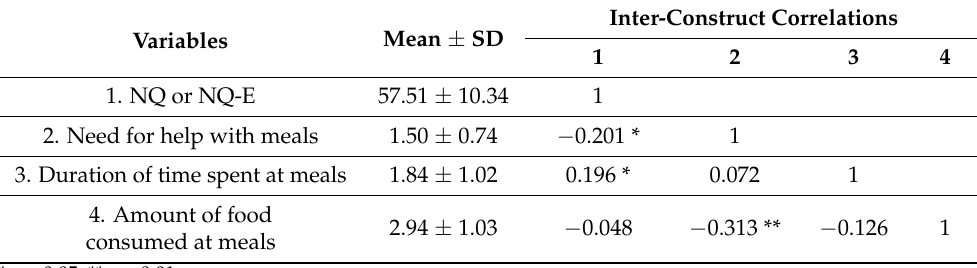
Table 9. Correlation between Nutrition Quotient/Nutrition Quotient for the Elderly Scores and Dietary Factors in